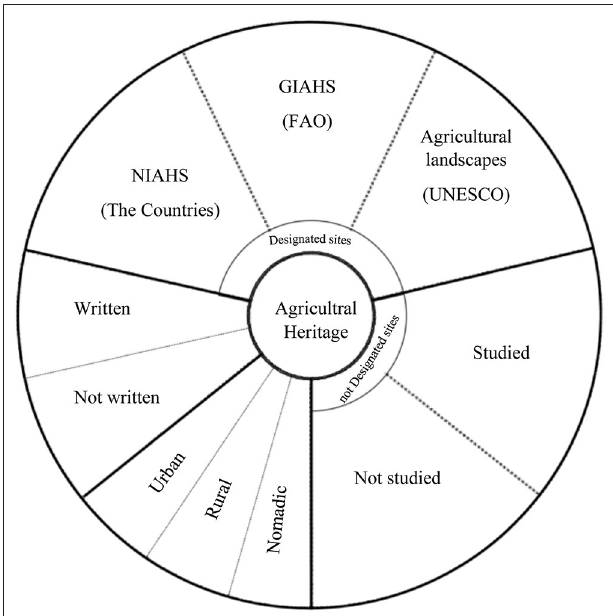
FIGURE 5 | Different dimensions of agricultural